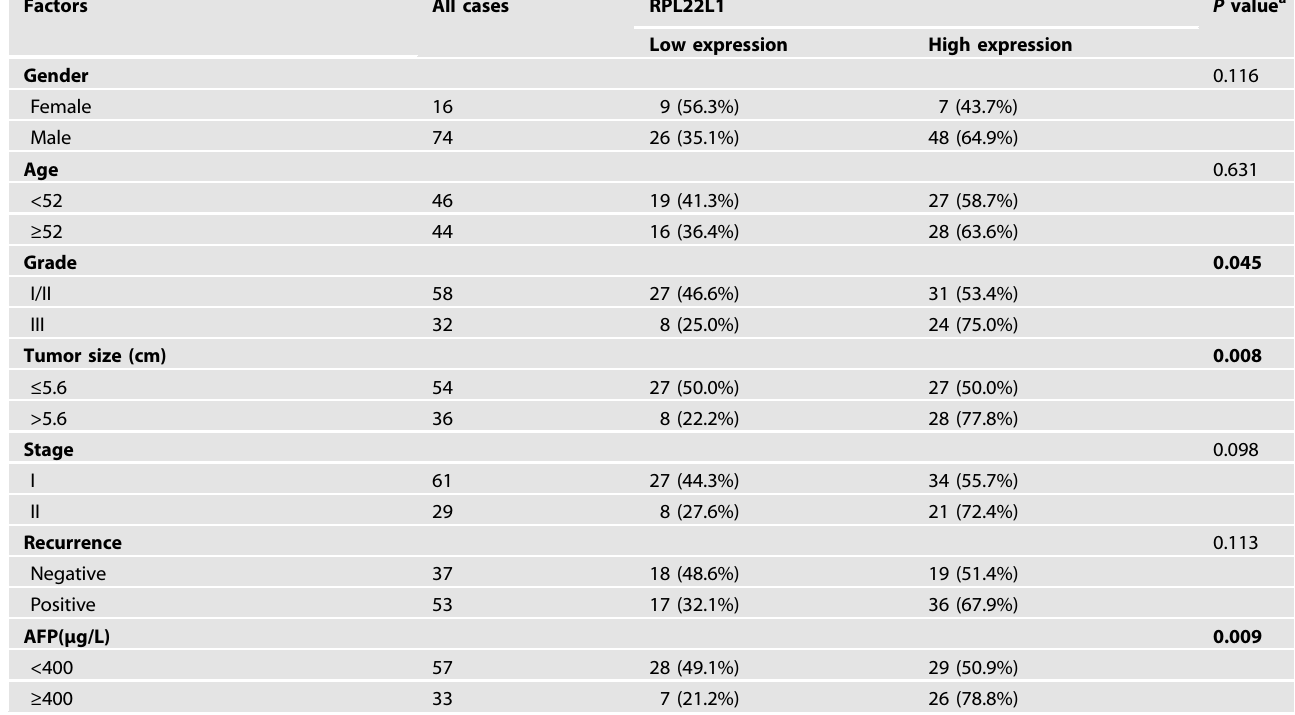
Table 1. Correlation between RPL22L1 expression and clinicopathological features of HCC in TMA.